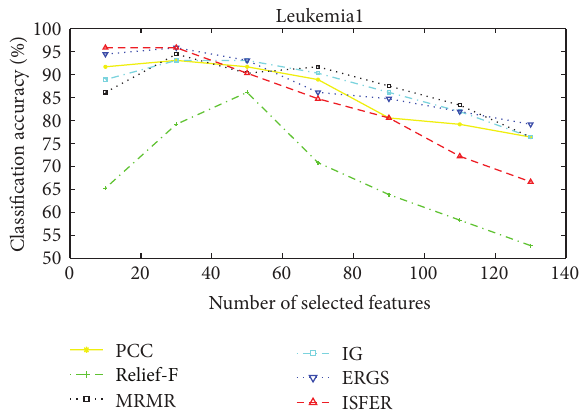
Figure 4: The classification accuracies of different algorithms on the Leukemia1 database.